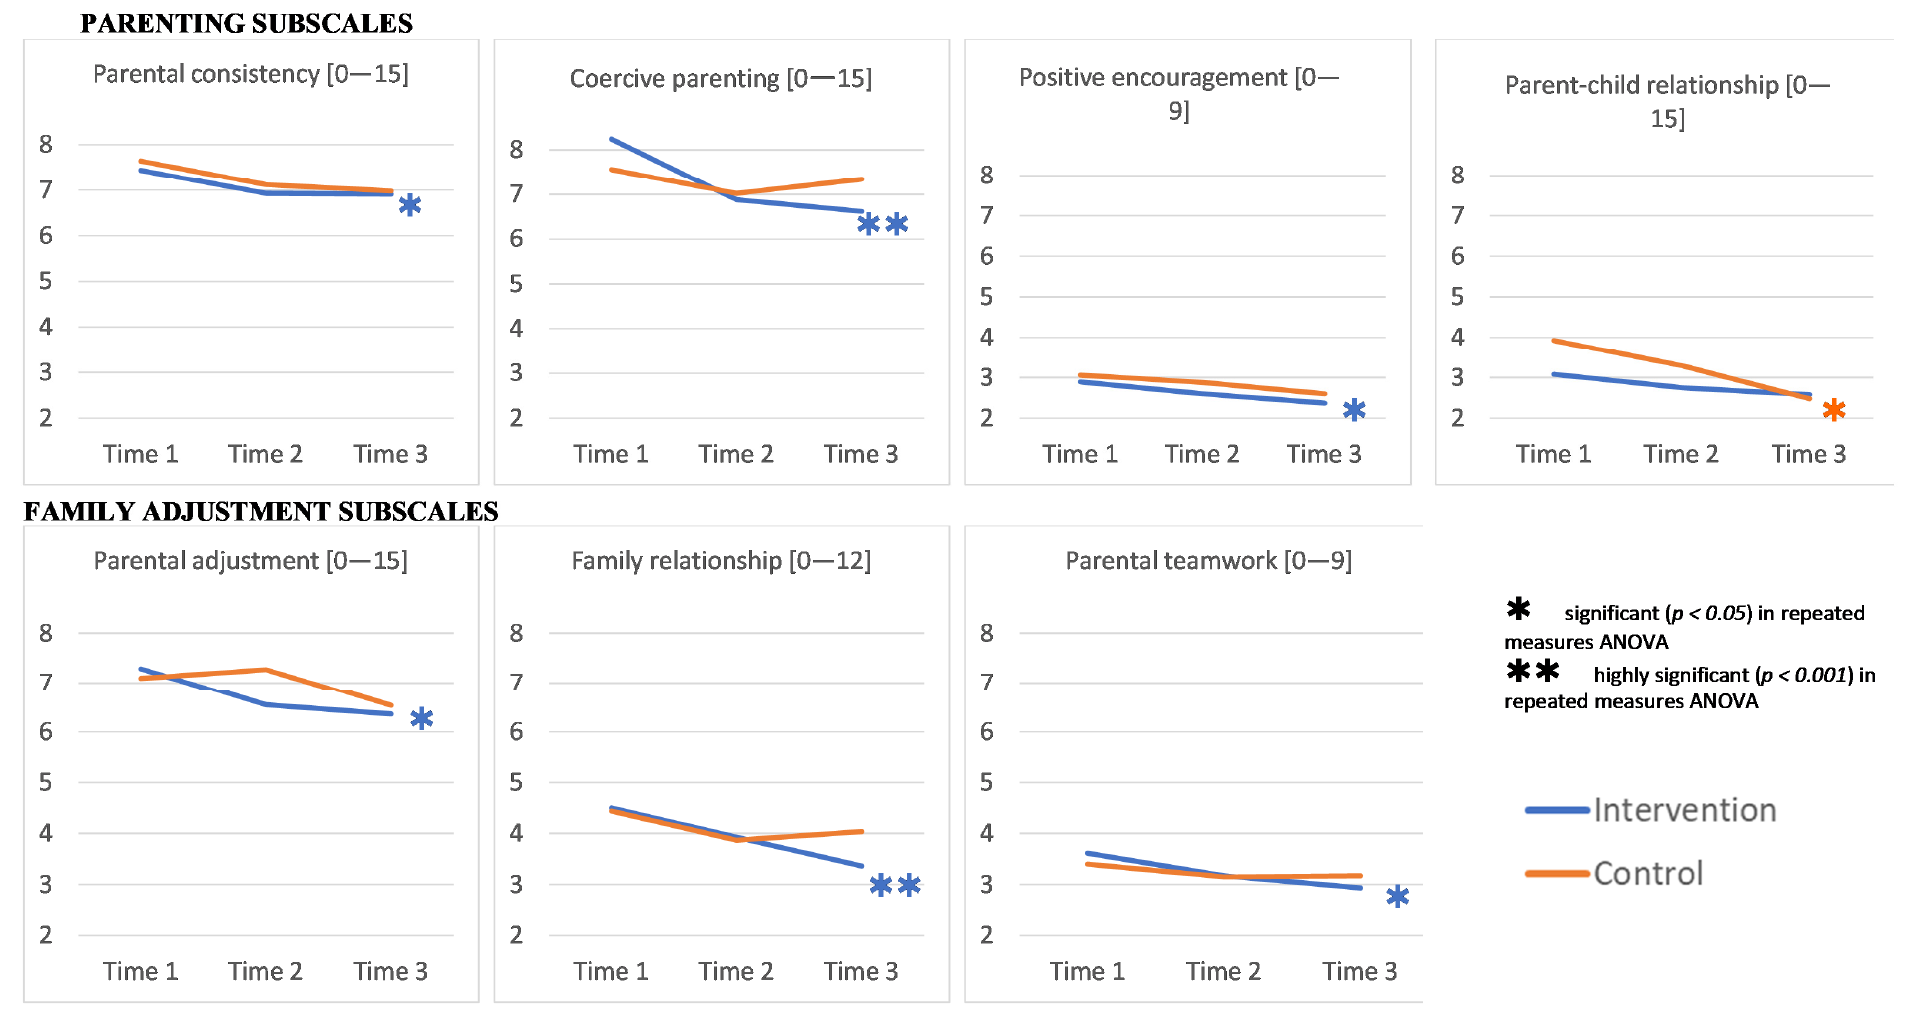
Figure 3. Overall parenting and family adjustment results comparing intervention and waitlist/control group ( higher scores indicating lower levels of Parenting and Family Adjustment skills ) .